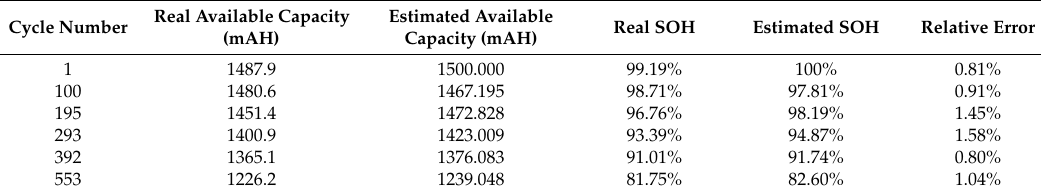
Table 8. Estimated error of No. 2 battery in test